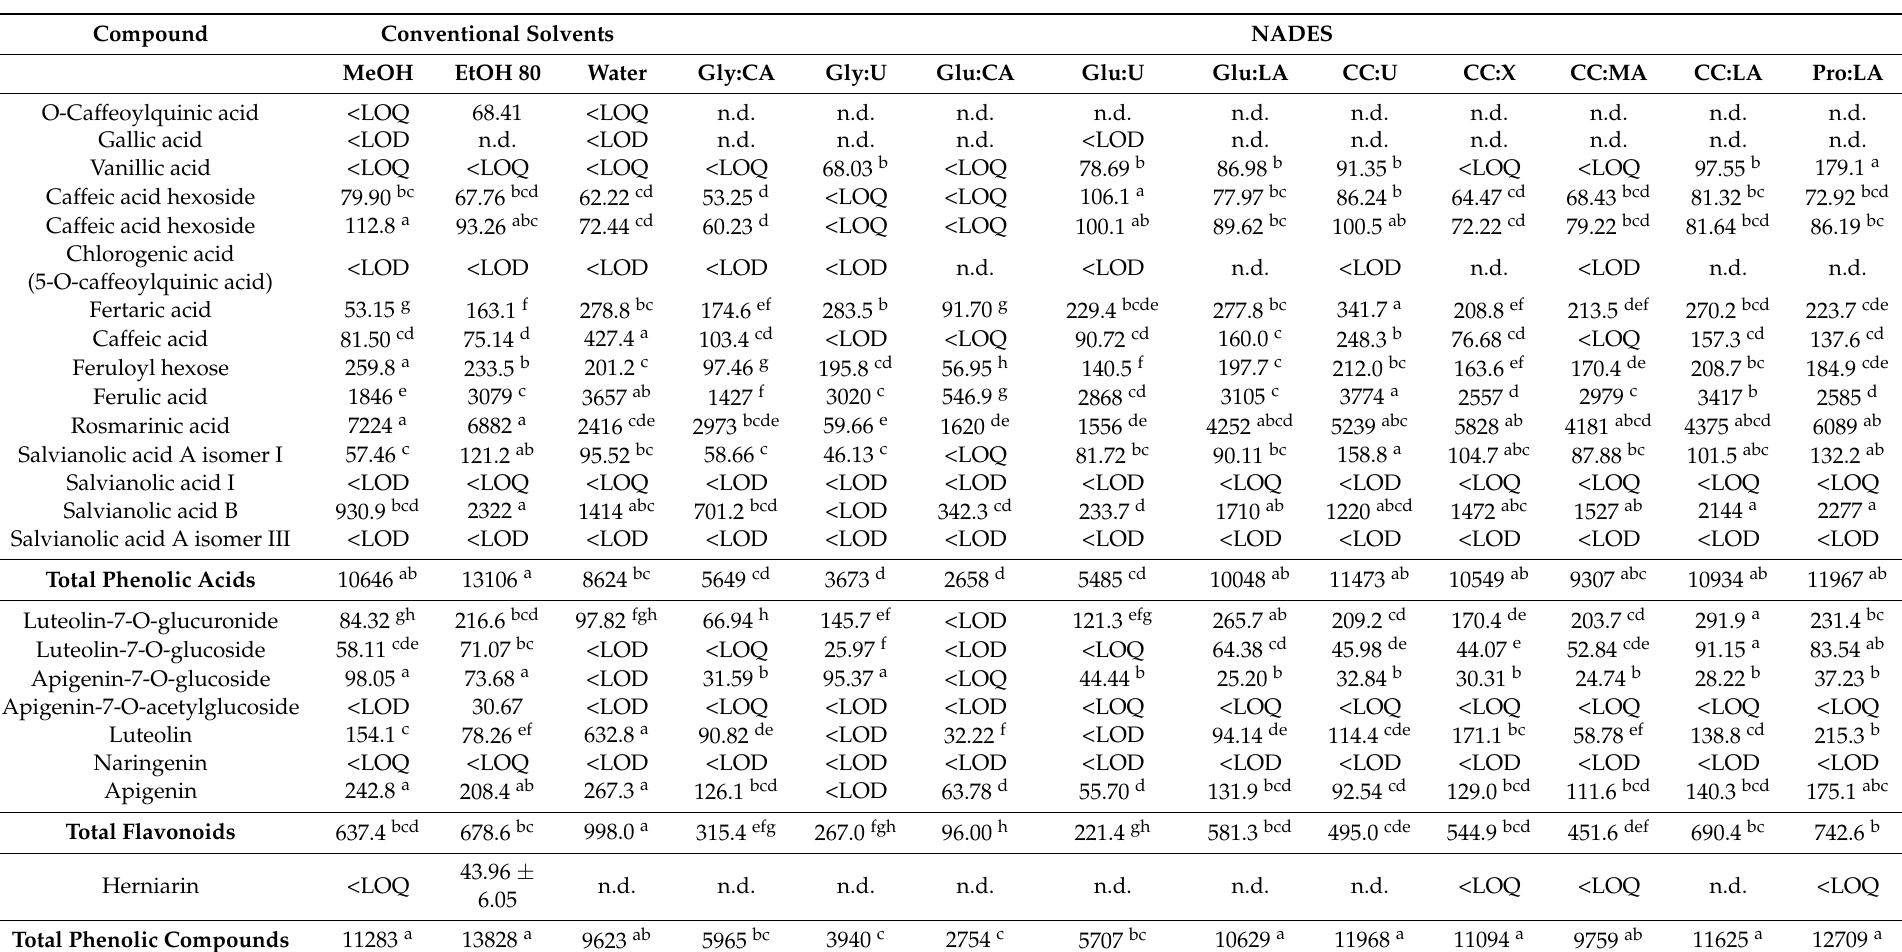
Table 2. Qualitative and quantitative ( µ g/g of extract, mean) analysis by high performance liquid chromatography-high resolution mass spectrometry (HPLC-HRMS) of phenolic profile from Lavandula pedunculata subsp. lusitanica extracts obtained by ultrasound-assisted extraction for 60